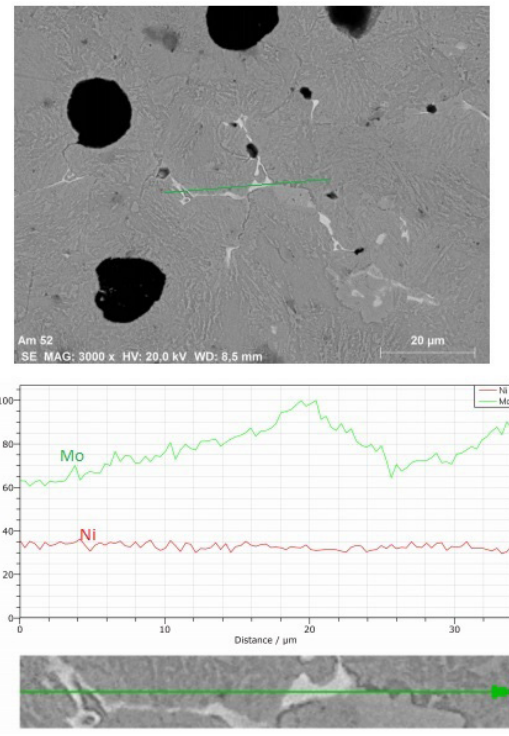
Figure 24. Cr/Cu EDS profile.